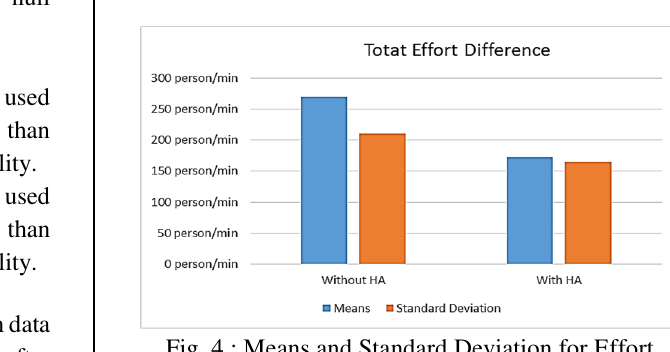
Fig. 4.: Means and Standard Deviation for